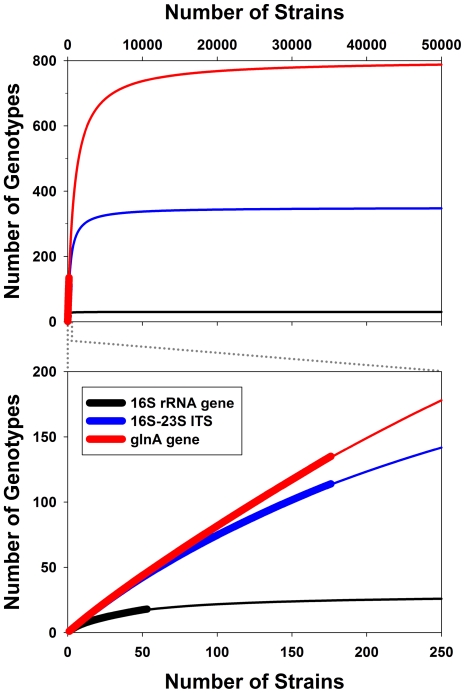
Diversity of P. necessarius ssp. asymbioticus as represented by a culture collection of 176 strains.The graphs show collector's curves depicting genotype numbers for the global non-redundant culture collection of P.n. ssp. asymbioticus strains (broad lines) after randomization of sampling order, as well as further extrapolations for continued collection of strains (thin lines). This non-redundant culture collection excludes all but one strain of the same genotype (ITS and glnA marker considered) isolated from the same habitat. Therefore, the collection includes only one (i.e. QLW-P1DMWA-1) of the twelve F10 lineage strains isolated from Pond-1 (compare Fig. 5). The collection consists currently of 176 strains isolated from various freshwater systems located all over the world. The sequencing of 16S rRNA genes of newly isolated strains was stopped after 53 strains. The length of the sequenced stretches of the markers 16S rRNA gene, 16S–23S ITS, and glnA were 1500 bp, 500 bp, and 600 bp, respectively. Note that genotype or species-richness predictions based exclusively on observed data usually underestimated the true richness. Randomization of sampling order was performed using the software EstimateS [75].